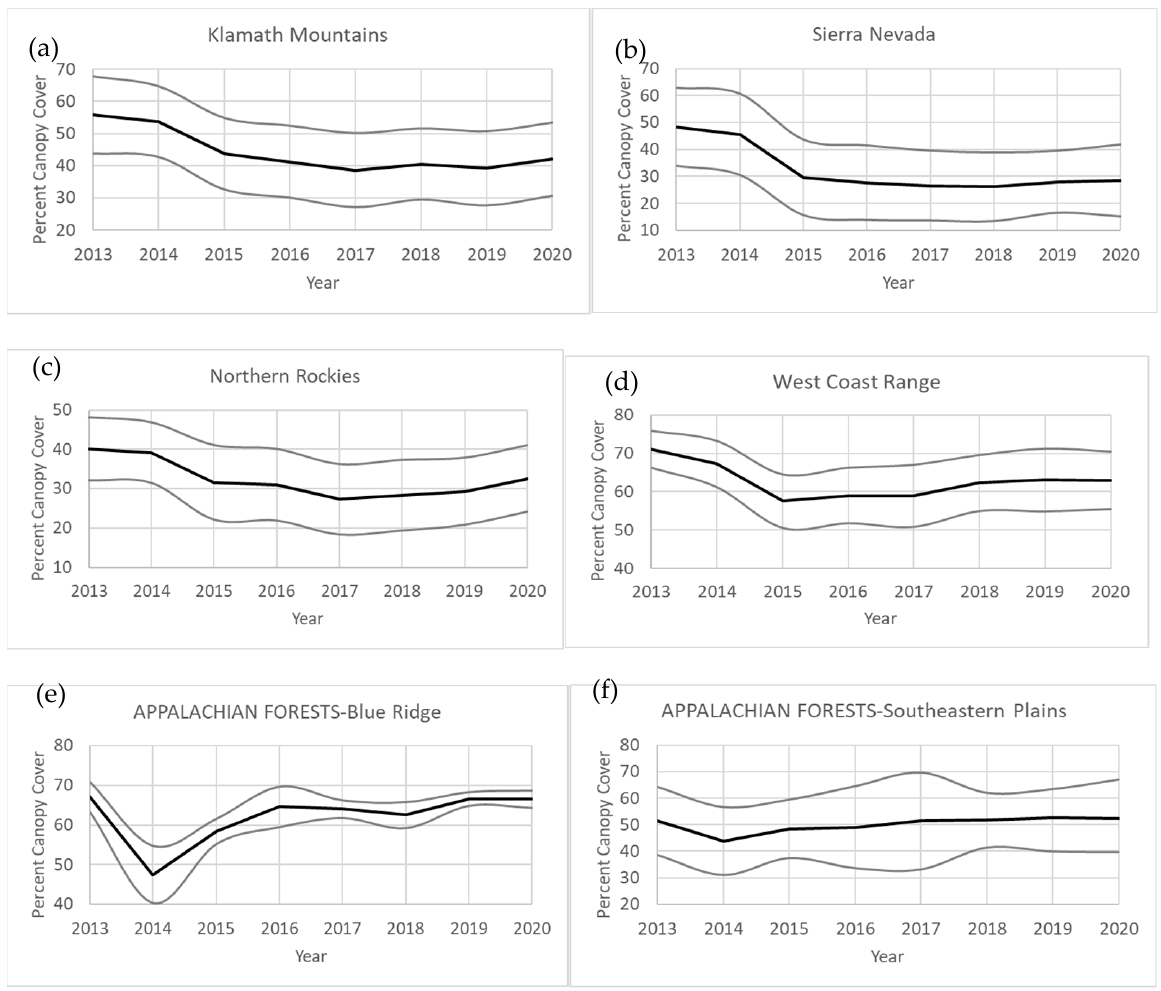
Figure 12. Post wildfires (2014) canopy cover dynamics 2014–2020 calculated from all pixels within the MTBS fire boundary for four fire-prone EPA level two ecoregions ( a – d ). These show very slow post-disturbance recovery of canopy cover. Faster cover recovery rates ( e , f ) were found for much of the Eastern forest such as in the Ozark/Ouachita–Appalachian forests blue ridge and southeastern Plains. Black lines represent the mean canopy cover values. Gray lines represent the mean ± 2 standard deviations of the distribution of values within the MTBS fire boundary.